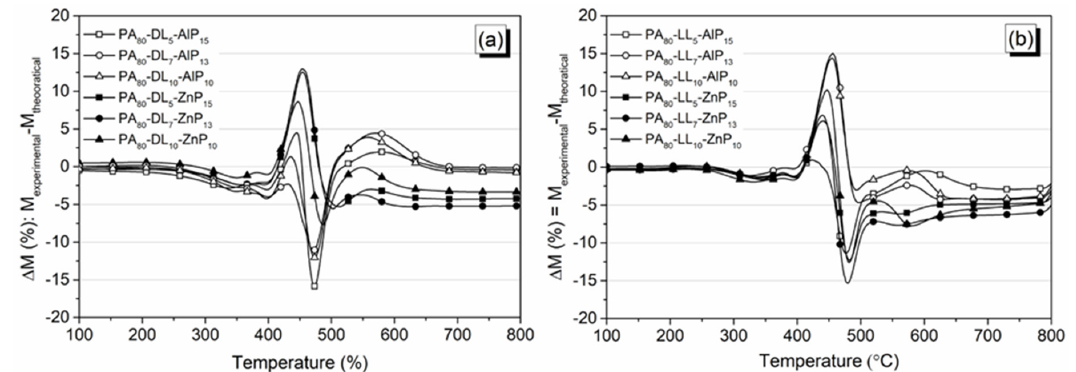
Figure 5. Curves of residual mass loss difference for polyamide 11 (PA11) ternary blends with lignosulphate lignin (LL) ( a ) and with kraft lignin (DL) ( b ) in air. Table 2. Thermogravimetric data for polyamide 11 (PA11) and its blends in N 2 and air.